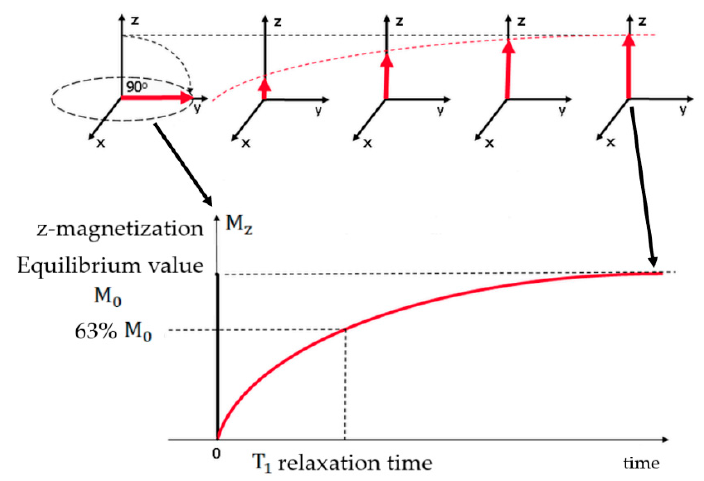
Figure 1. T 1 relaxation process. Diagram of the T 1 relaxation when a 90 ◦ RF pulse was applied to a system at equilibrium. M z is reduced to zero, but then returns gradually to its equilibrium value if no further RF pulses are applied. Adapted from Ridgway, J.P. “Cardiovascular magnetic resonance physics for 7clinicians: Part I.” J. Cardiovasc. Magn. Reson. 12 (2010) 71.